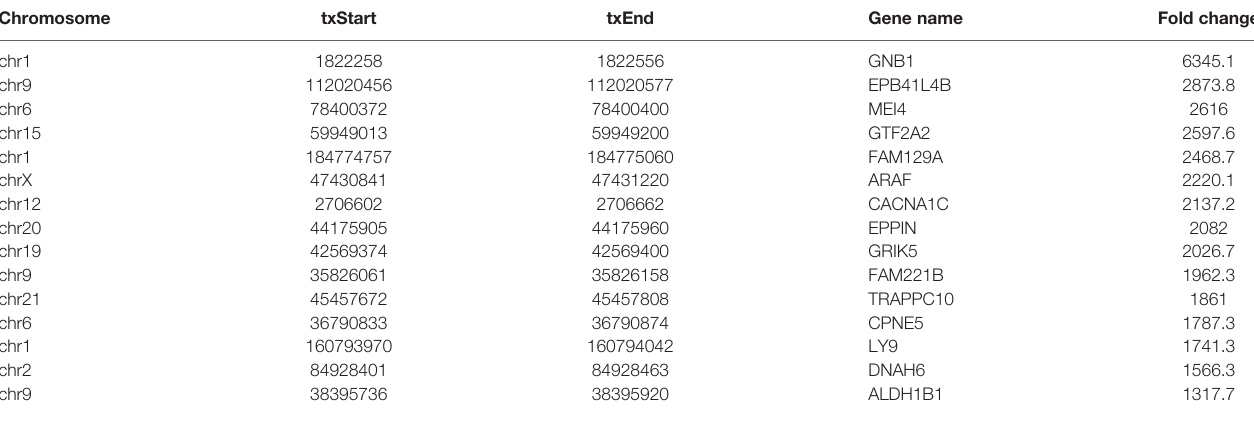
TABLE 1 | Top 15 up-methylated genes (HL60/MX2 vs HL60). Chromosome